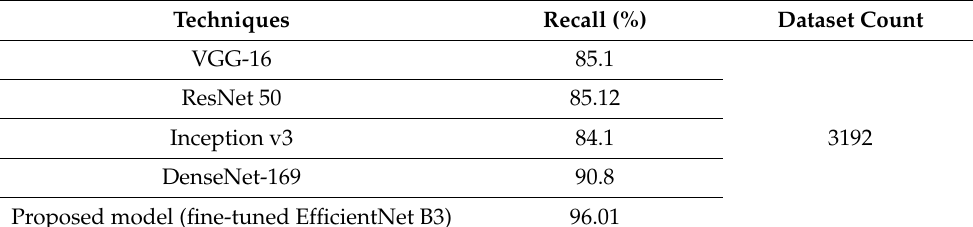
Table 9. Accuracy calculation for monkeypox disease detection results using the reinforcement learning approach. Figure 18. Analysis of Reinforcement learning algorithm for the classi fi cation of monkeypox. Figure 18. Analysis of Reinforcement learning algorithm for the classification of monkeypox. Table 7. Recall calculation for detection of monkeypox disease detection.